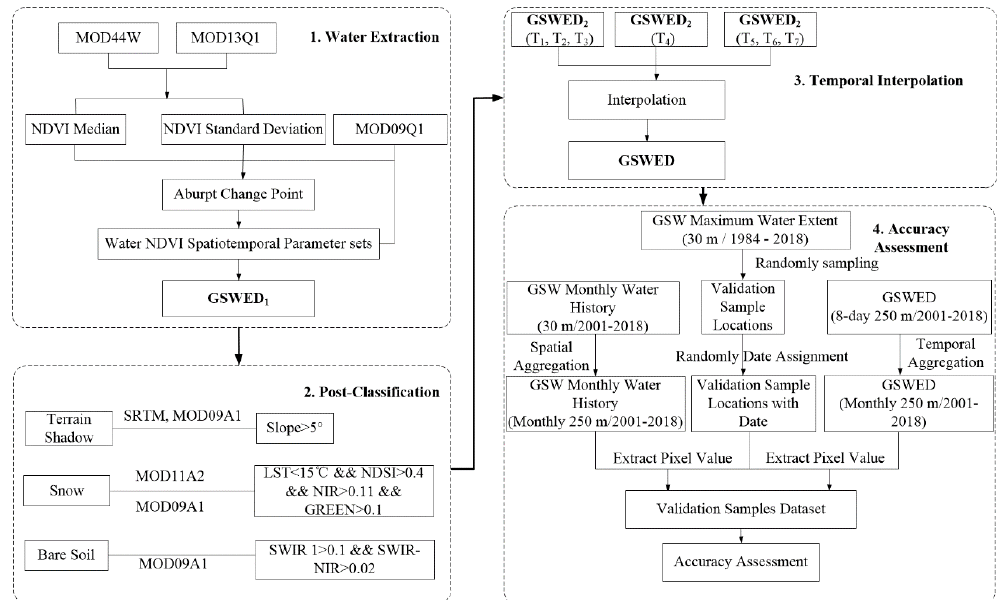
Figure 1. Workflow of global surface water extent extraction. (Normalized Difference Snow Index (NDSI); Land Surface Temperature (LST); Global Surface Water Extent Dataset 1 (GSWED 1 ) indicates the preliminary global surface water dataset; Global Surface Water Extent Dataset 2 (GSWED 2 )